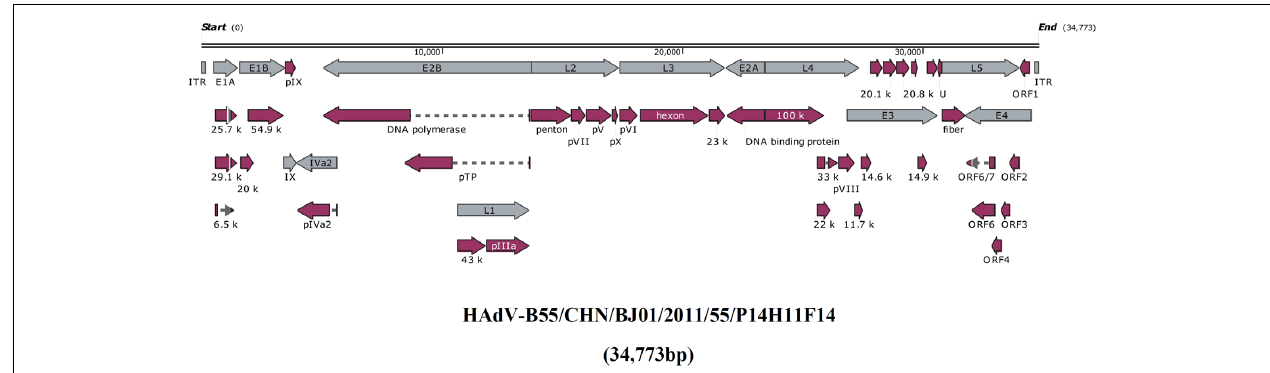
FIGURE 1 | Transcriptional map and genome organization of HAdV-B55 strain BJ01. The genome is indicated by two black horizontal lines marked at 10,000 bp intervals. Early, intermediate, and late transcription units are designated by gray arrows, while the red designates coding regions. Arrows reflect the transcriptional orientation of the coding